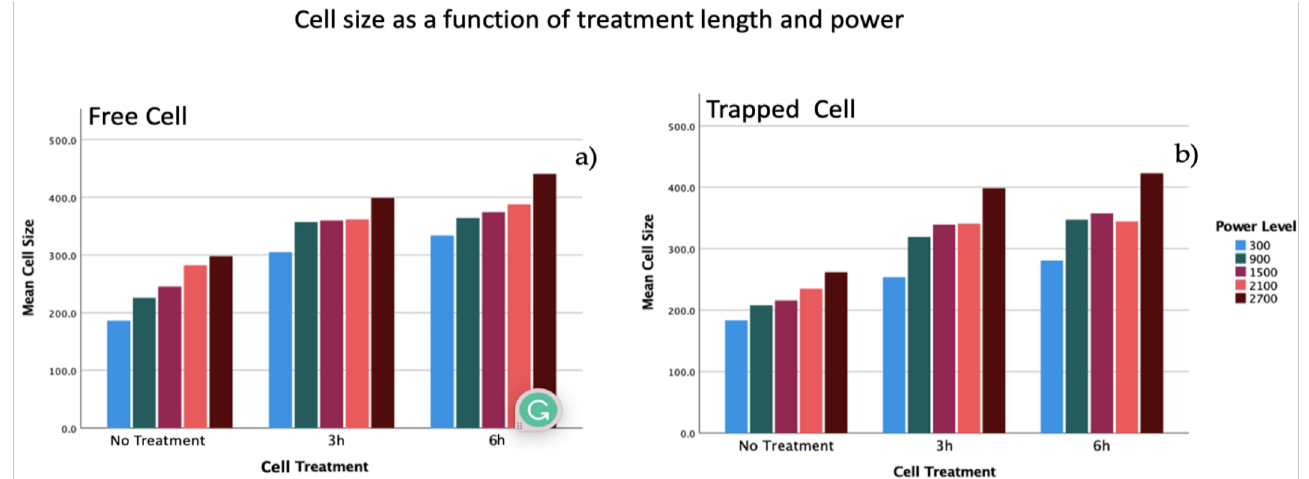
Figure 5. Cell size as a function of the treatment length and power: ( a ) mean size of the free cell at different treatment times; ( b ) mean size of the trapped cell at different treatment